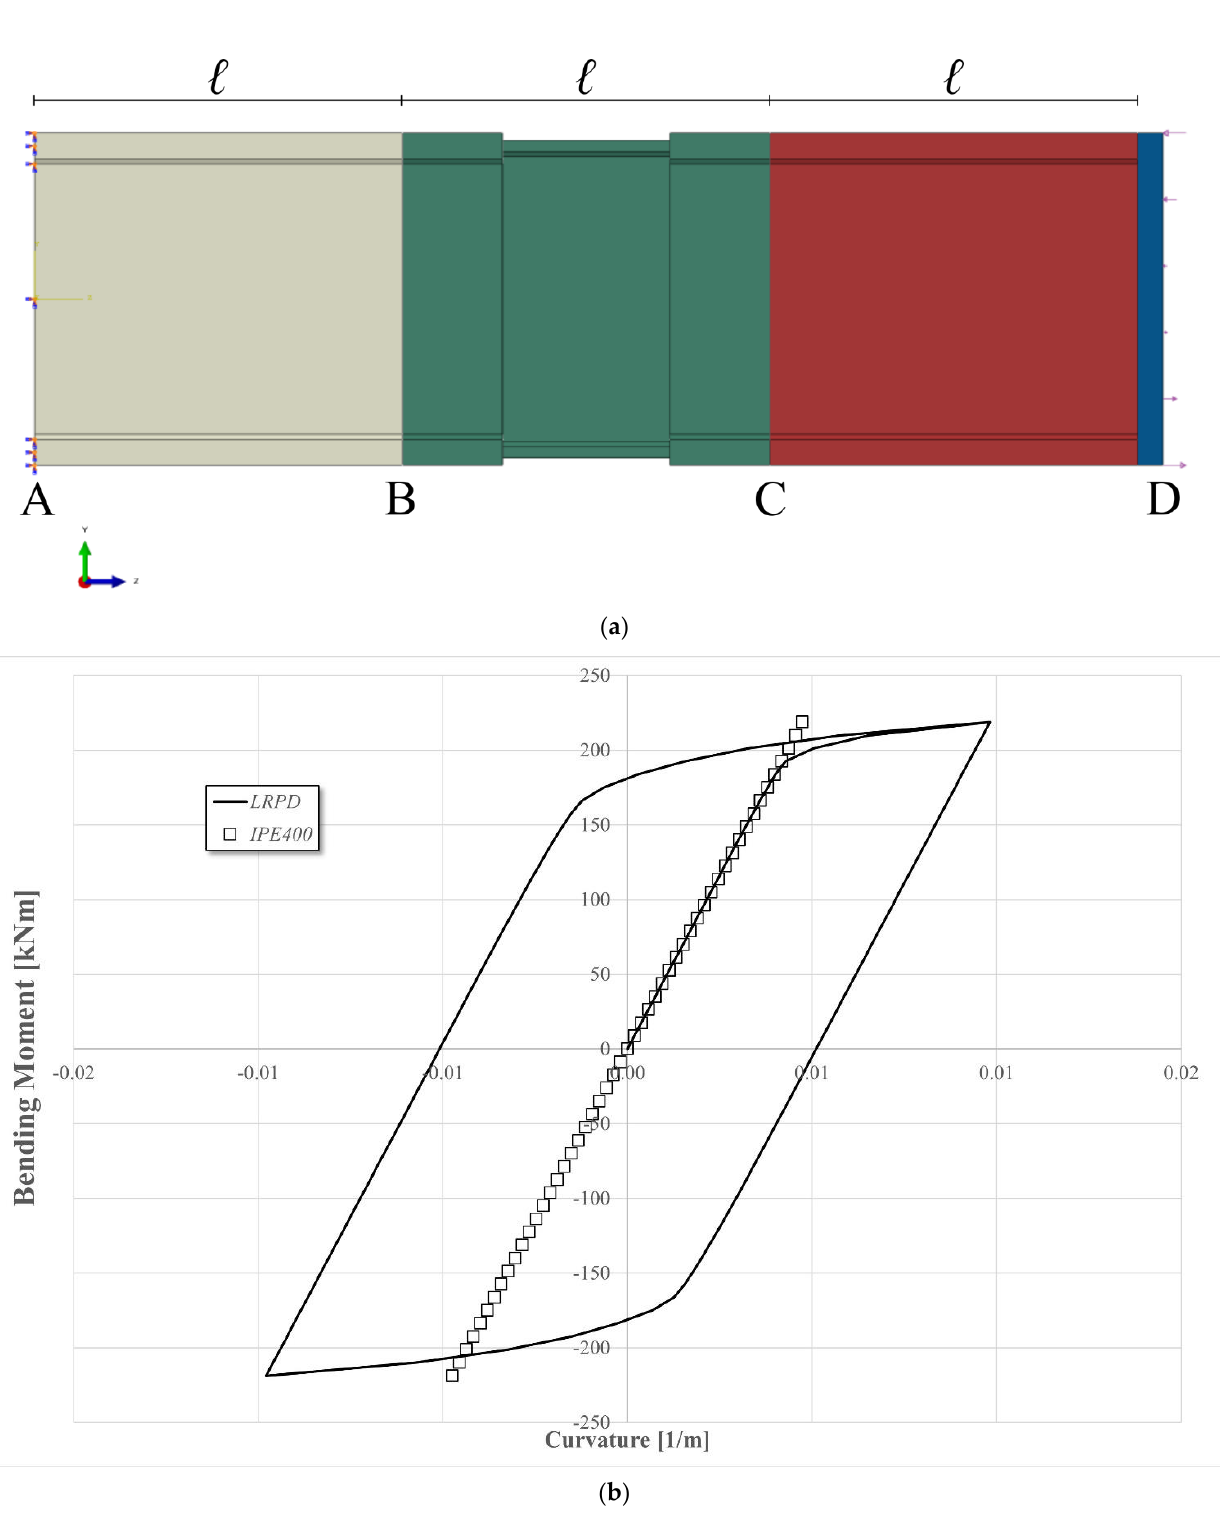
Figure 19. Cyclic analysis for IPE400 LRPD (DP1): ( a ) lateral view of the model; ( b ) bending moment vs. bending curvature curve.